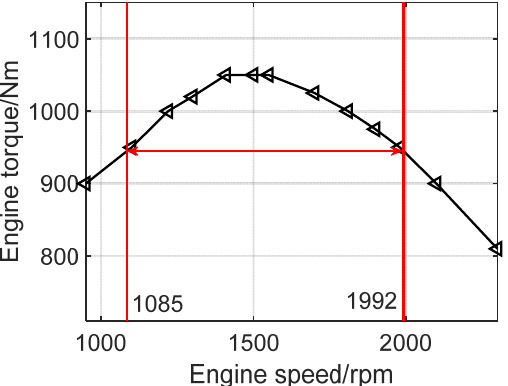
Figure 5. External characteristic curve of diesel engine used.